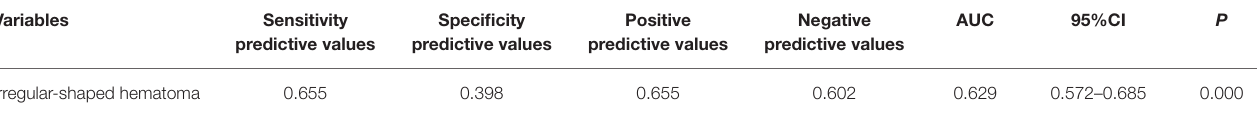
Specificity Positive Negative AUC 95%CI P predictive values predictive values predictive values predictive values